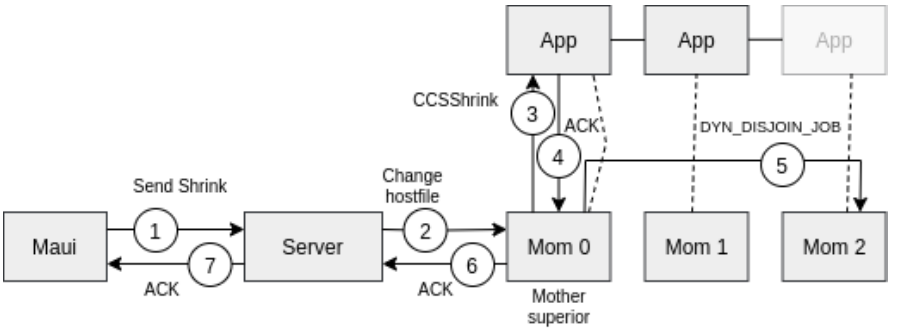
Figure 7. Expanding a job by adding nodes 2 and 3 [47]. Based on: http://charm.cs.illinois.edu/ newPapers/15-12/paper.pdf (accessed on 7 May 2022). Adapted with permission from [47]. Copy- right 2014, Suraj Prabhakaran.